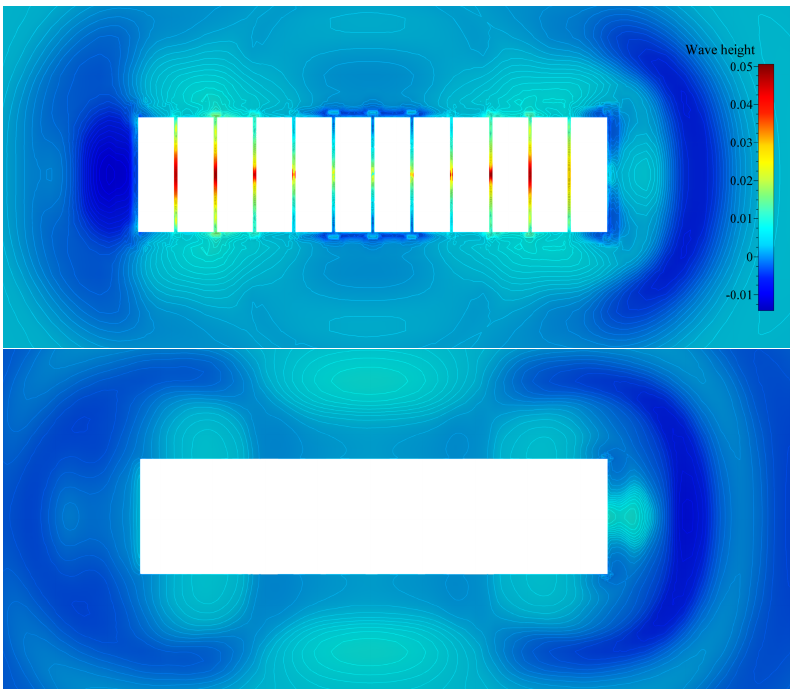
Figure 5. Top view of free surface elevation contours for the first mode of vertical vibration (seg- mented hull—top image, monohull—bottom